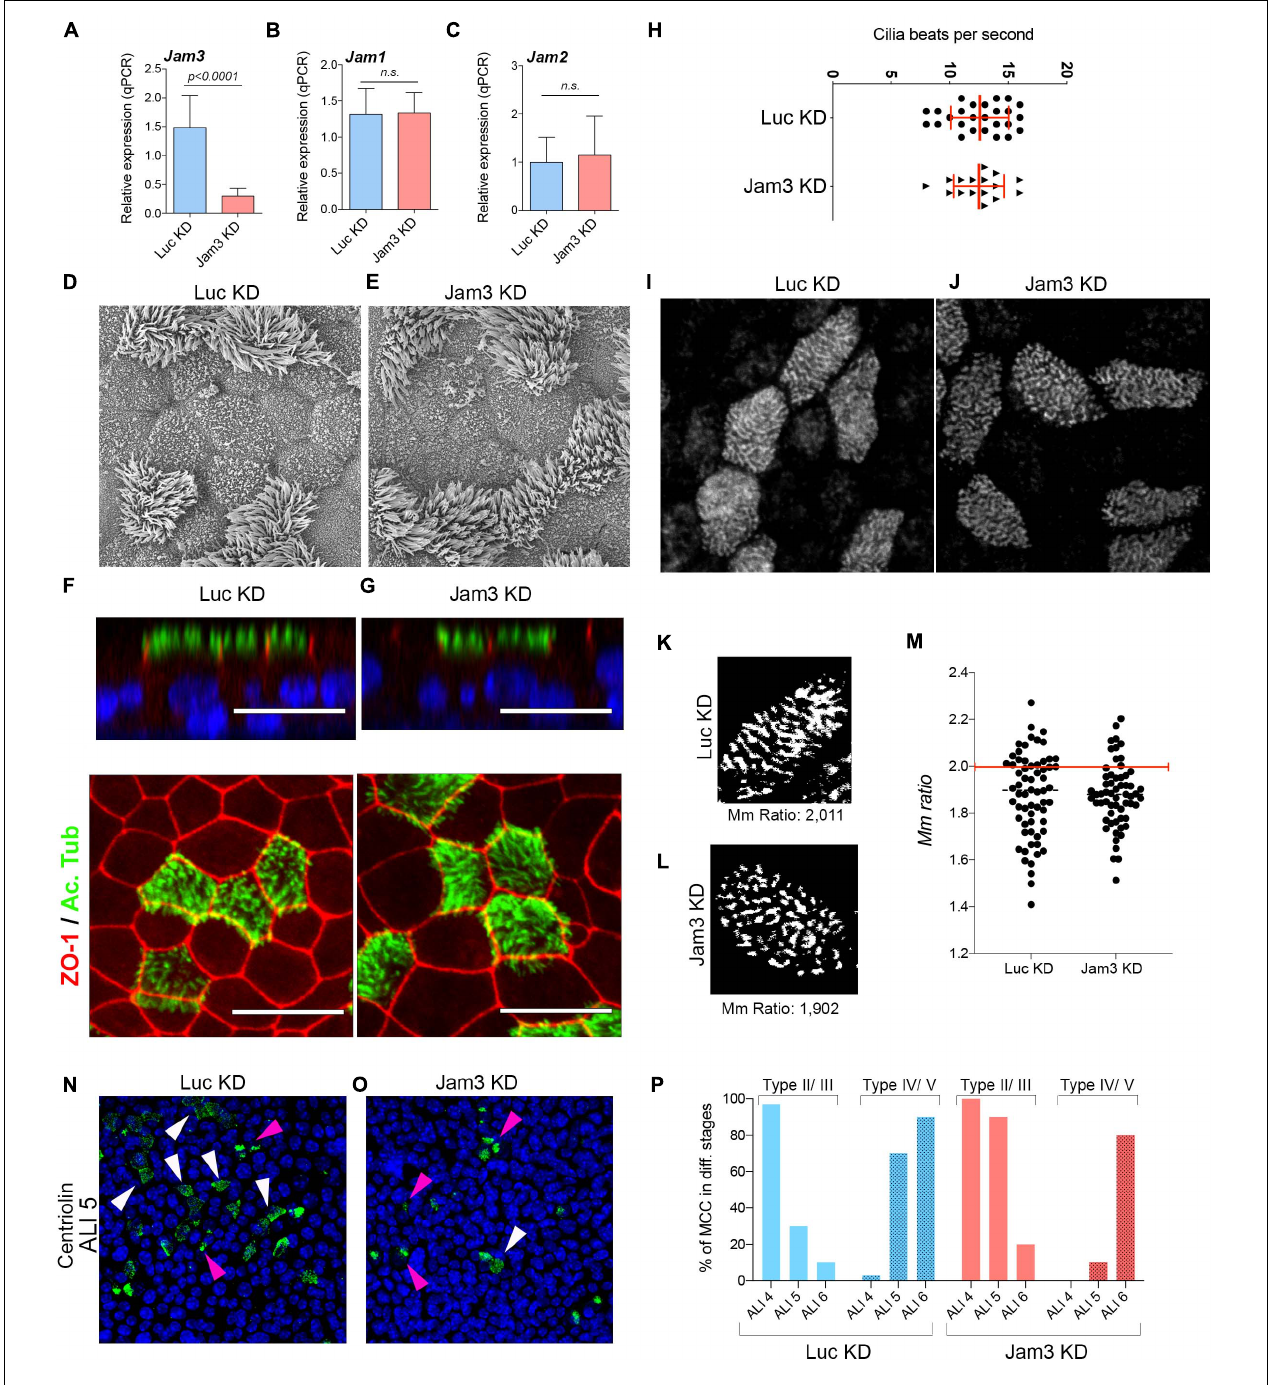
FIGURE 4 | Downregulation of Jam3 does not alter cilia structure and function. (A–C) Mean mRNA expression levels of Jam3 (A) , Jam1 (B) , and Jam2 (C) assessed in differentiated MTECs infected with control viruses (Luc KD) or Jam3-shRNAs (Jam3 KD), n = 3. (D,E) Scanning electron micrographs of Jam3-KD and control (Luc KD) MTECs differentiated for 14 days. (F,G) Lateral and top views of confocal images for acetylated tubulin (in green), ZO-1 (in red), and nucleus (in blue) in Jam3-KD (G,G’) and Luc KD (F,F’) MTECs. (H) Cilia beating frequency quantification as number of beats per second in cells treated with Luc KD and Jam3 KD MTECs. (I,J) Basal body staining in control (I) and Jam3 KD cells (J) . (K,L) Black and white image obtained to calculate the Mm ratio in a control cell (K) and a Jam3 KD cell (L) . (M) Mm ratio quantification for individual cells. n > 60 in Control and Jam3 KD conditions. (N,O) Centriolin staining in control (Luc KD) and Jam3-KD cells in ALI 5. (P) Quantification of MCCs in different stages of differentiation in control and Jam3 KD cells. Type II/III are those cells with Centriolin staining in aggregates (pink arrowheads) while Type IV/V are those cells with Centriolin staining dispersed at the apical membrane (white arrowheads). Scale bar in panels (F,G) represent 20 µ m. p -values in all conditions were obtained using t